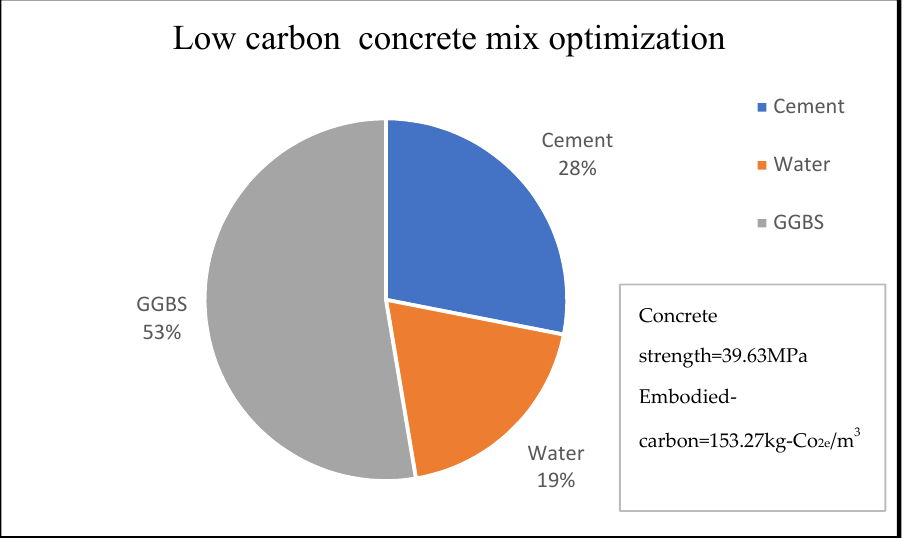
Figure 3. LCC constituent material at water content of 19% [33]. Table 11. Concrete mix optimisation extracted from [22].